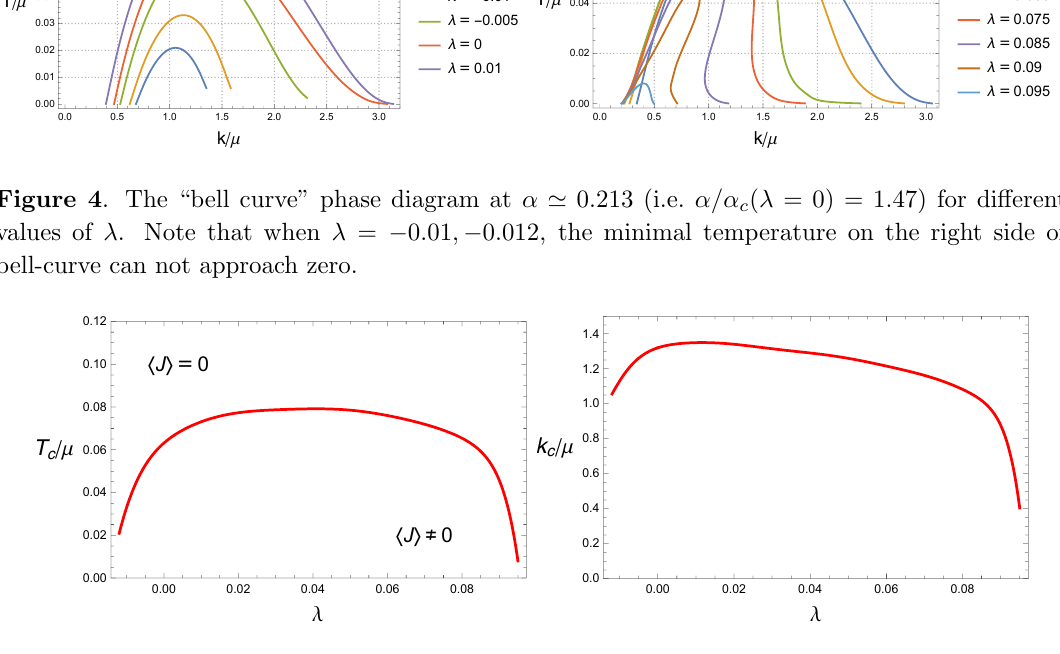
and di(cid:11)erent values of (cid:21) . The \bell-curve" behavior in the literature [1] is not qualitatively modi(cid:12)ed by the mixed gauge-gravitational anomaly. Actually we (cid:12)nd the bell-curves are consistent with the BF bound violation region at zero temperature, as shown in the red region of the right plot of (cid:12)gure 3. When we increase (cid:21) from negative values the red island (see (cid:12)gure 3) becomes wider very fast, similar as we observe in left plot of (cid:12)gure 4. On the other hand, the upper momentum shows a turning point in (cid:12)gure 3 at some positive (cid:21) , such that the island becomes narrower. We observe a similar behavior in the right plot